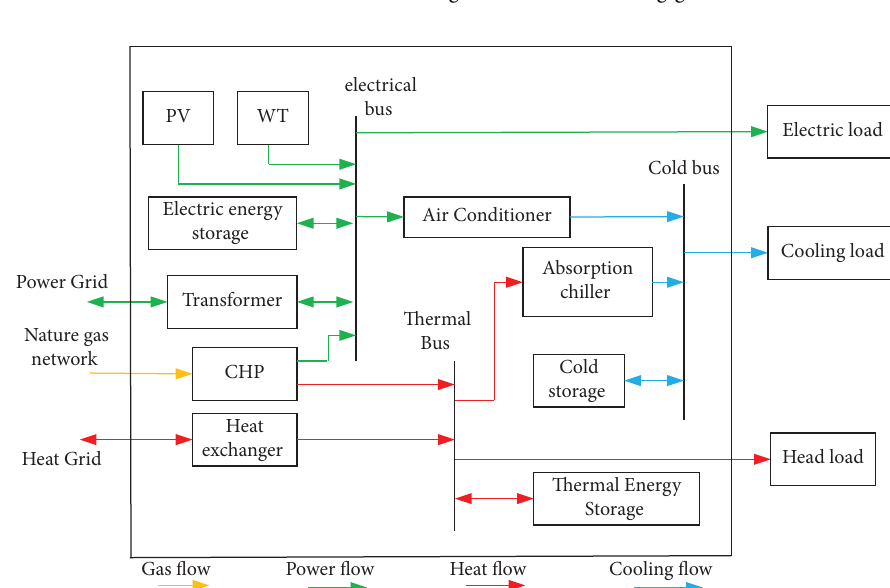
Figure 1: Te schematic diagram of the Stackelberg game.